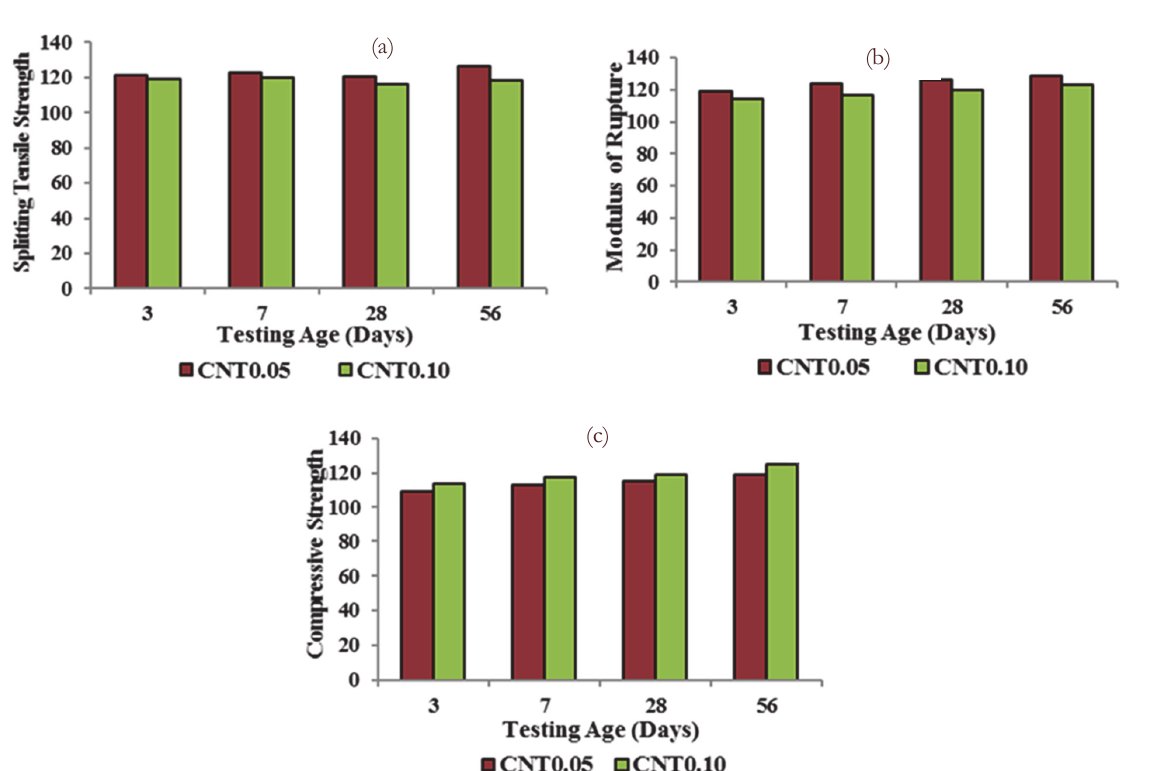
Figure 5: Strength activity indices for concrete mixes containing MWCNTs (a) Splitting tensile strength, (b) Flexural strength, and (c) Compressive